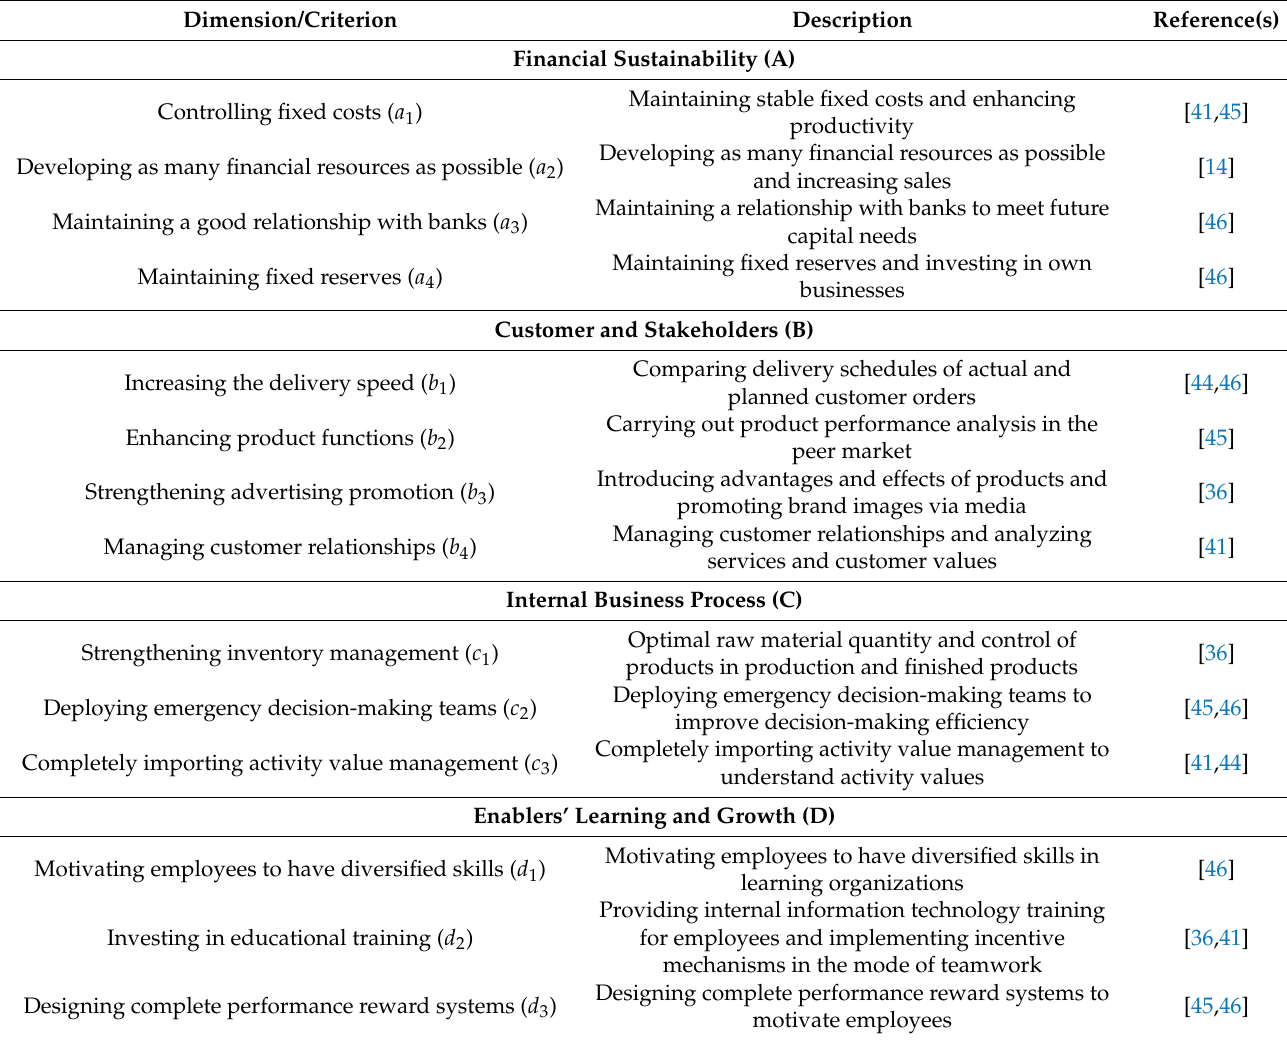
Table 4. The results of essential criteria selected using ELMC + DRST and K =